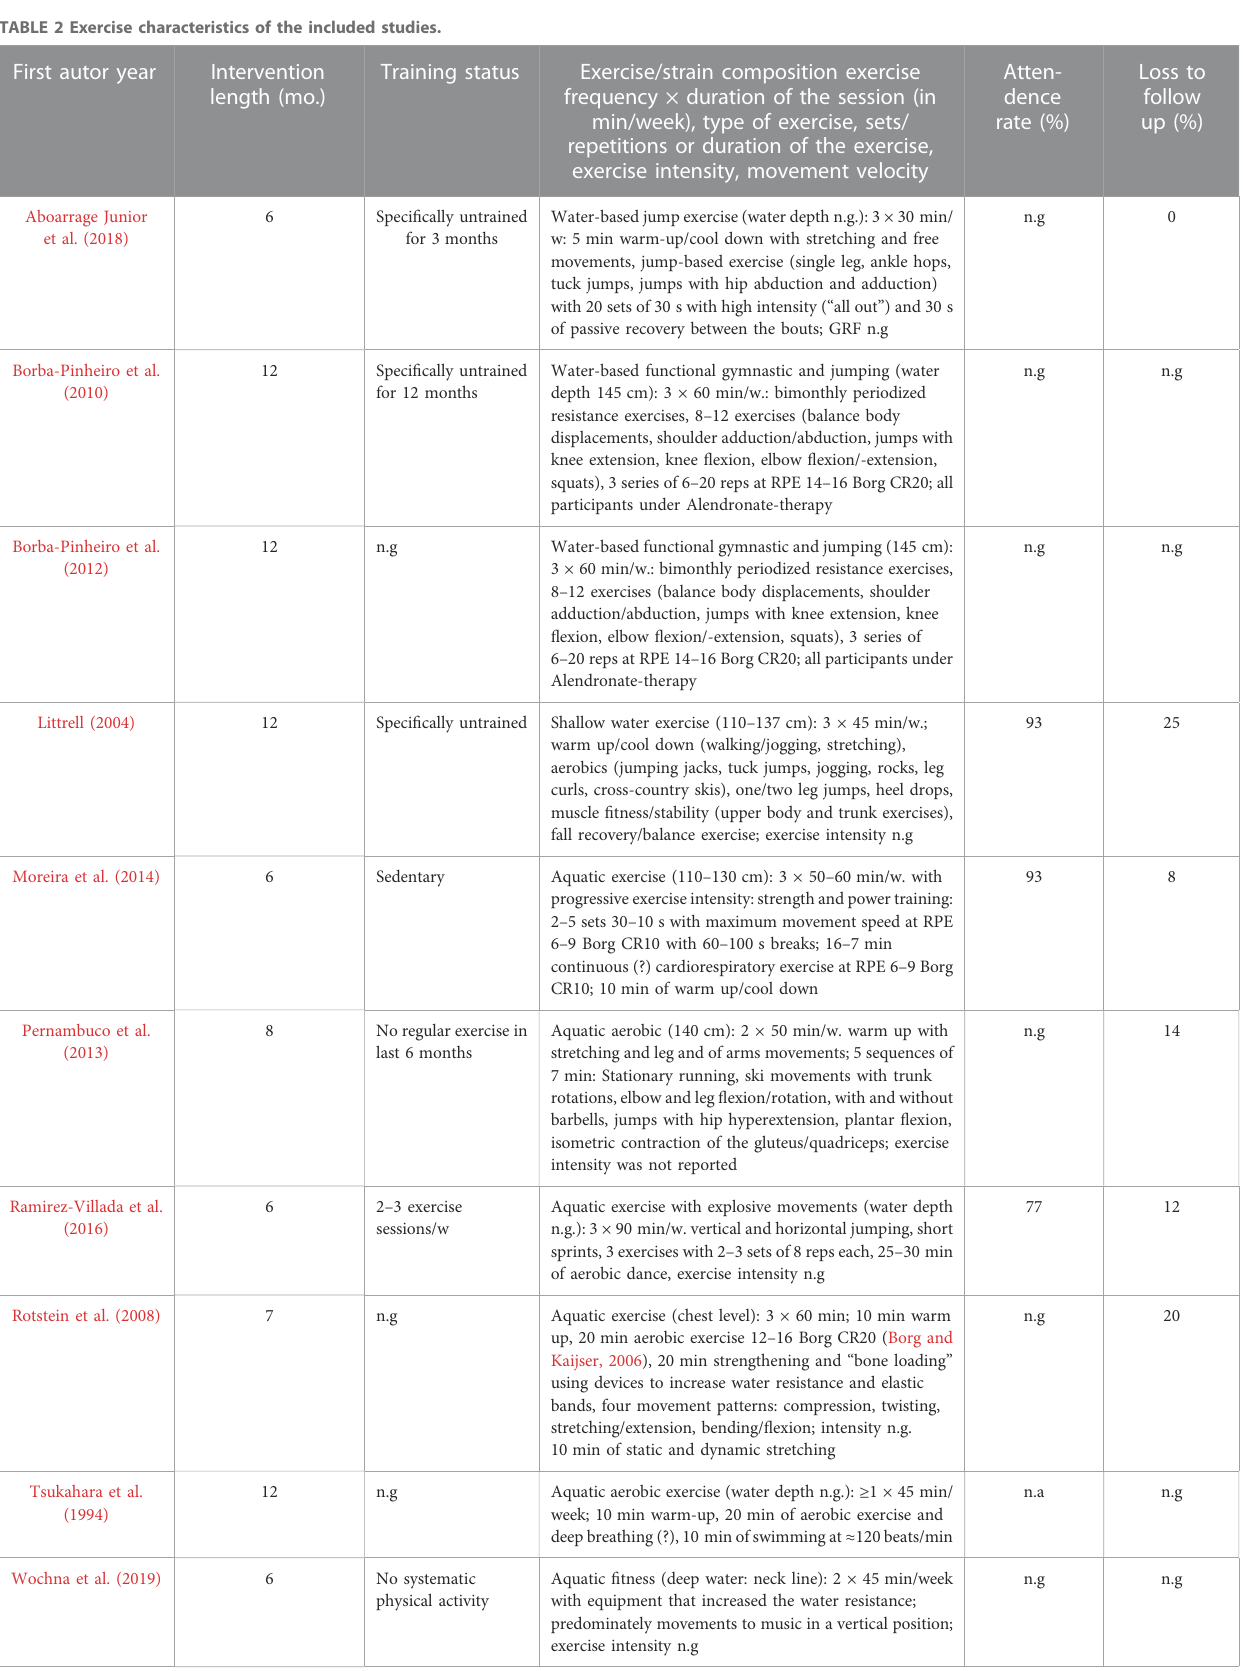
TABLE 2 Exercise characteristics of the included